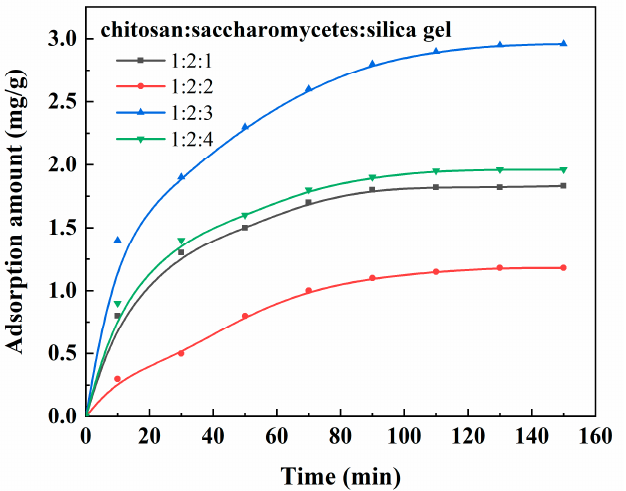
Figure 9. Adsorption property of the porous chitosan/saccharomycetes microspheres with the ratio of chitosan to saccharomycetes and silica gel for doxycycline. of chitosan to saccharomycetes and silica gel for